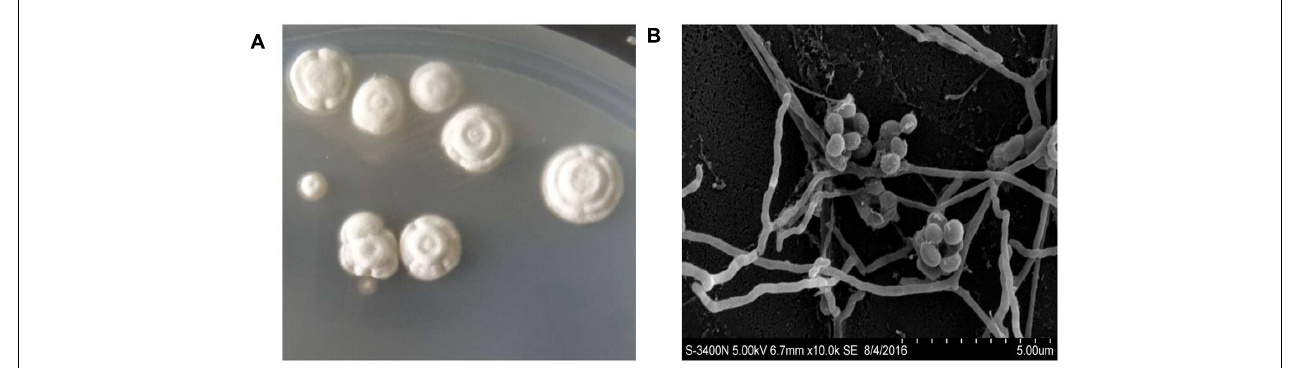
FIGURE 3 | Characteristics of Streptomyces sp. NHF165. (A) Colony characteristics of Streptomyces sp. NHF165. (B) Scanning electron micrograph of Streptomyces sp. NHF165 grown on GT agar at 28 ◦ C for 7 days. Bar = 5 µ